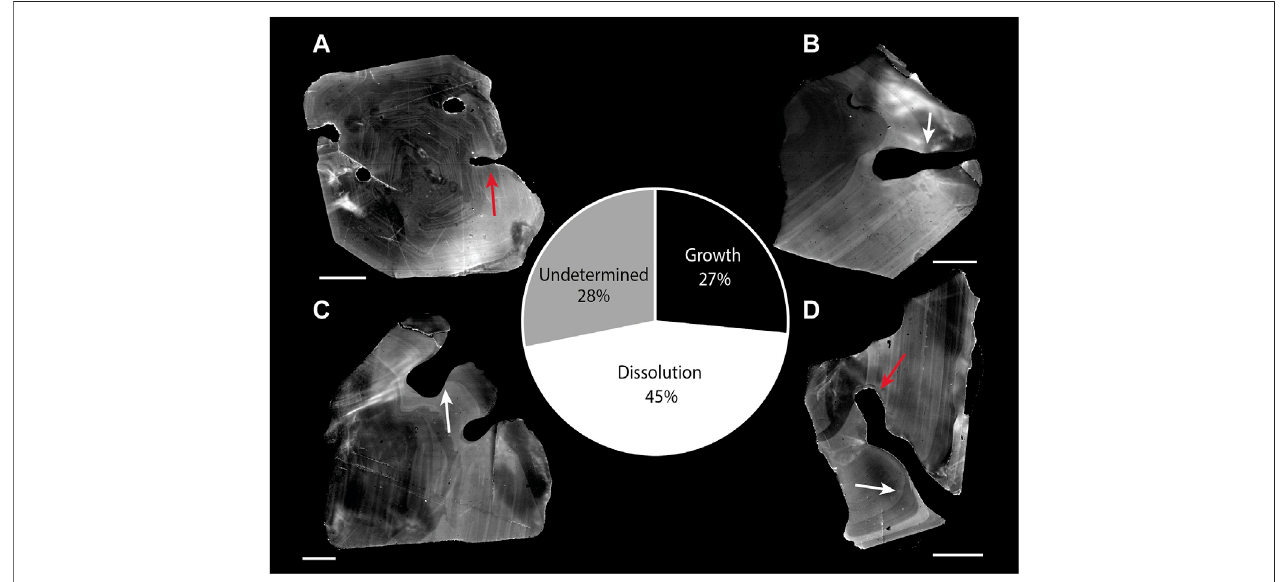
FIGURE 6 | Cathodoluminescence (CL) images of Bandelier Tuff (A) and Huckleberry Ridge Tuff quartz crystals (B – D) . Red arrows indicate dissected bands whereas white arrows indicate de fl ected CL bands. (D) quartz preserves periods of both growth and dissolution. Pie chart visualizes results from CL analysis of embayments in quartz prepared for this study and those compiled from the literature ( n (cid:1) 181 embayments). Scale bars are 200 µm.